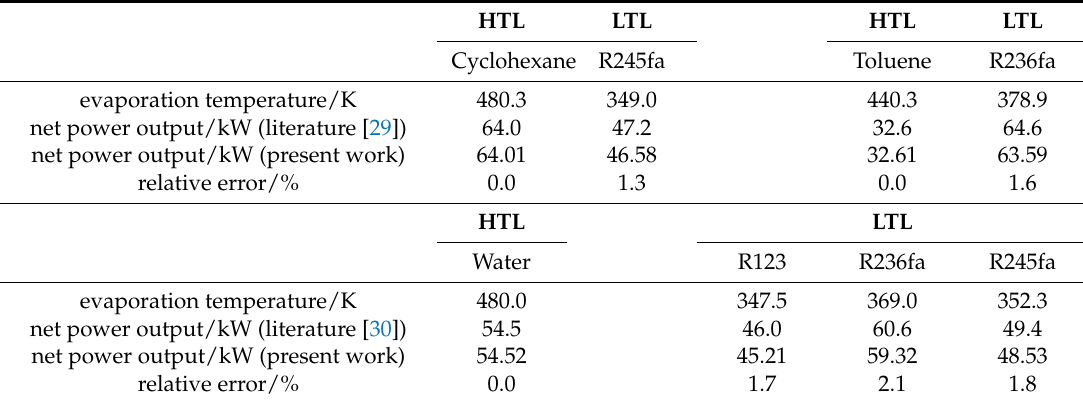
Table 3. Data comparison between the present work and the literature.